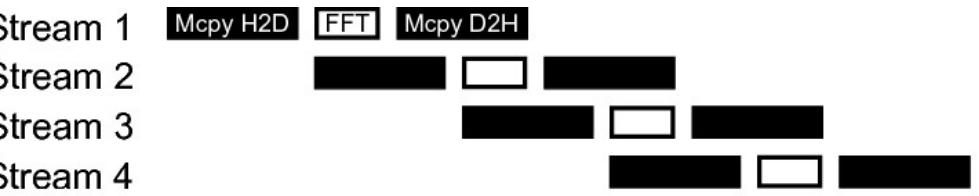
Figure 2. Schematic of CUDA stream use to overlap data transfer from the host to the device (H2D) with cuFFT host to the device (H2D) computation. Each stream operates on only a section of the data block. The data is transferred asynchronously, and the computation starts on a stream as soon as the data transfer is complete. Black “Mcpy H2D” (“D2H”) boxes indicate copies of the data from the host to the device (or vice versa), while white “FFT” boxes correspond to the computation of the FFTs on the data available in that